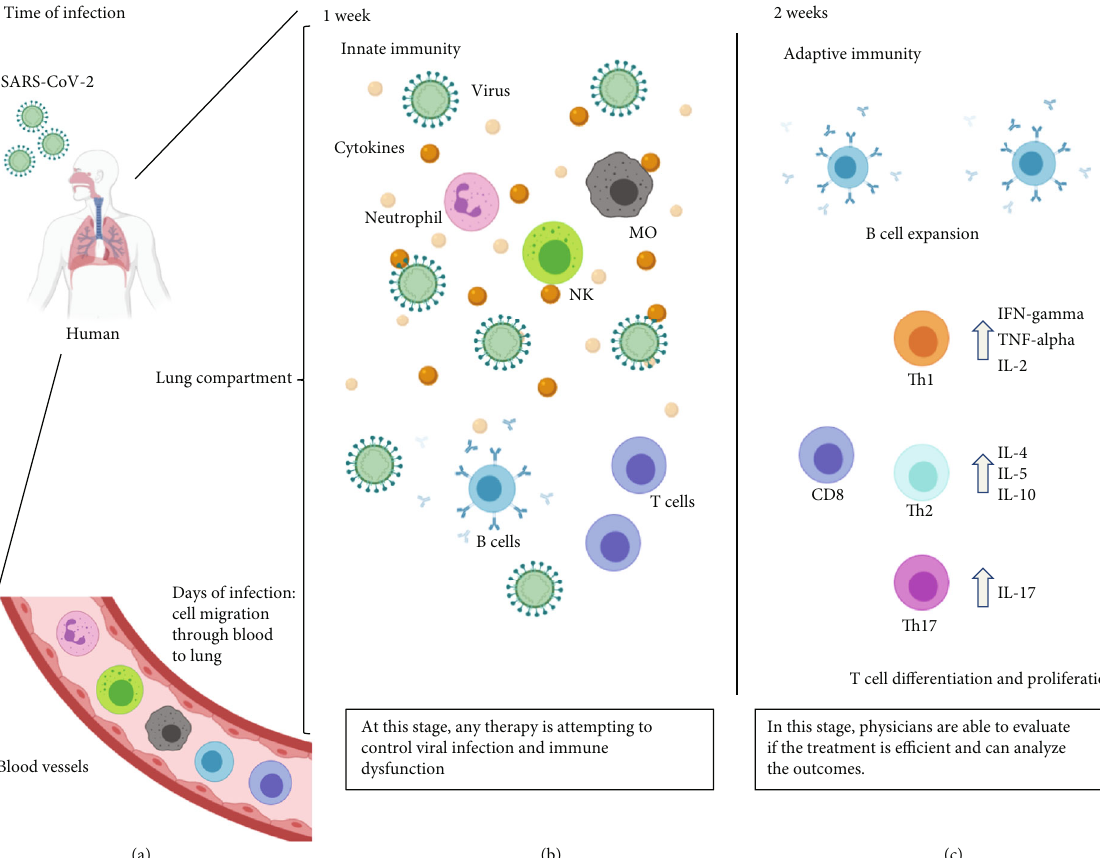
Figure 1: Immune response during COVID-19. (a) After SARS-CoV-2 contact with the respiratory tract of a human, susceptible cells are infected by entry through ACE2 or CD147 surface receptors. Once in the lung compartment, the fi rst line of defense made of dendritic cells and other cells, such as macrophages, are able to recruit other immune cells. Then, cell migration through blood vessels are directed to the lung compartment, where cell activation occurs, initiating the in fl ammation process on the fi rst week of signals and symptoms (b), inducing natural killer cell (NK), neutrophil, and macrophage (MO) activation in the lungs, causing the phenomenon called “ cytokine storm. ” In the mean time, B cells are producing antibodies, and immature T cells are also activated attempting to control the viral infection, although apoptotic events can also occur, reducing the number of T cells in the lungs and in the peripheral blood. After that, in two or more weeks (c), adaptive immune response is raised to speci fi c IgG and neutralizing antibodies to contribute to the recovery and viral elimination. At this time, CD8 T cells are activated as cytotoxic phenotype, with the same aim, driving towards virus elimination. Meanwhile, the di ff erentiation of CD4 T cells can trigger for more help for viral elimination by Th1 cells, but it can also lead to more lung damage by in fl ammatory phenotypes, such as Th2 and Th17 cells. Physicians and clinicians should evaluate each case to introduce the immunotherapies attempting to control the immune dysfunction. Created with